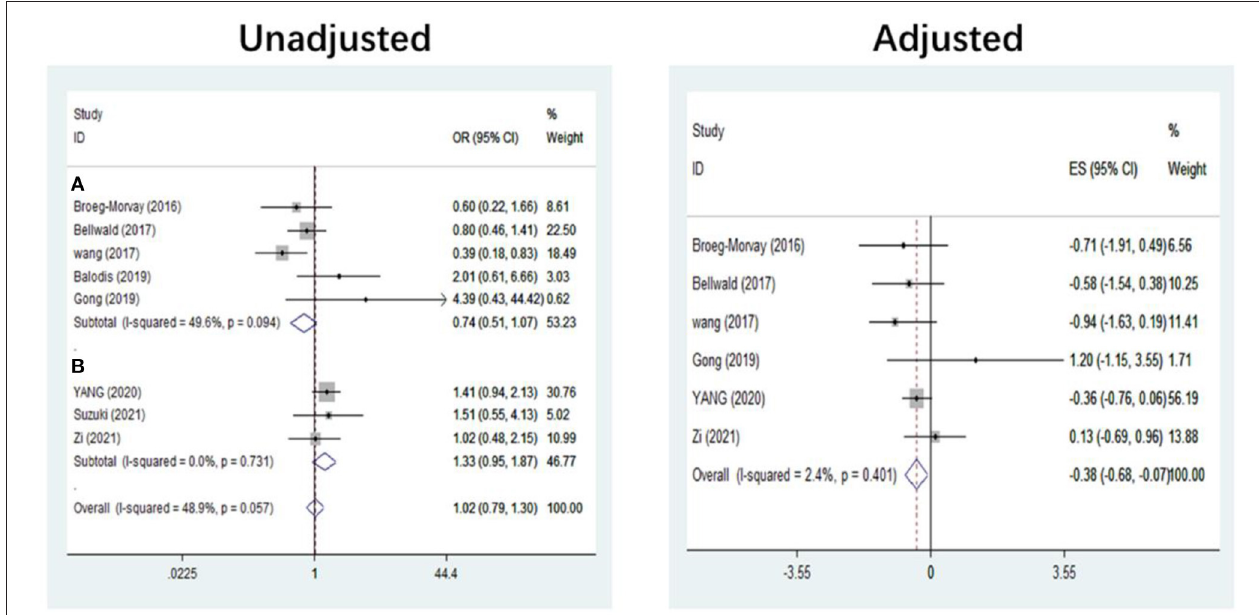
FIGURE 4 | Recanalization. (A) Non-RCT. (B) RCT. RCT , randomized controlled trial; ES , effect size.